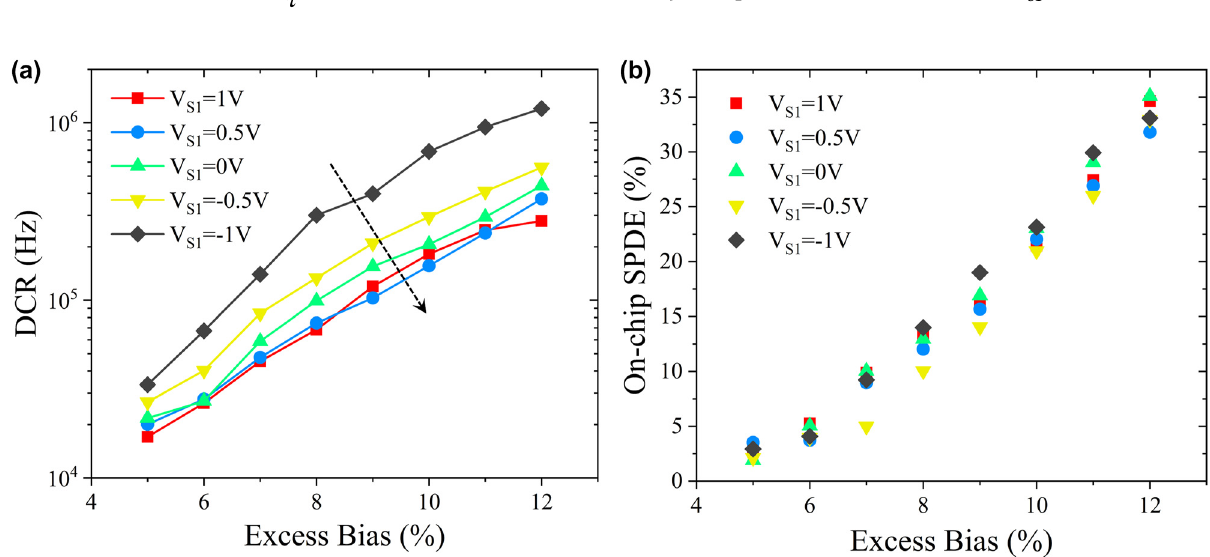
Figure 6: DCR and on-chip SPDE of the detector. (a) DCR of the detection system versus the excess bias with different V versus the excess bias with different V